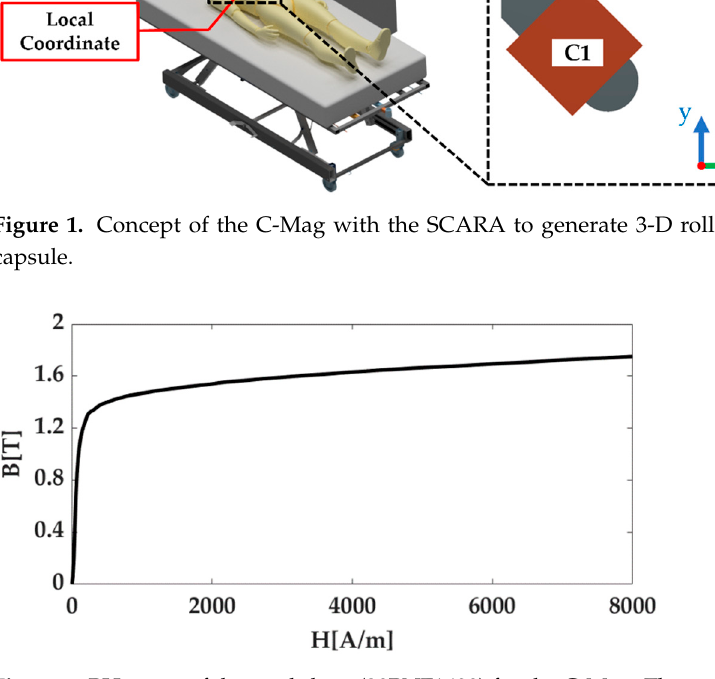
Figure 2. BH curve of the steel sheet (30PNF1600) for the C-Mag. These data are provided courtesy of POSCO.